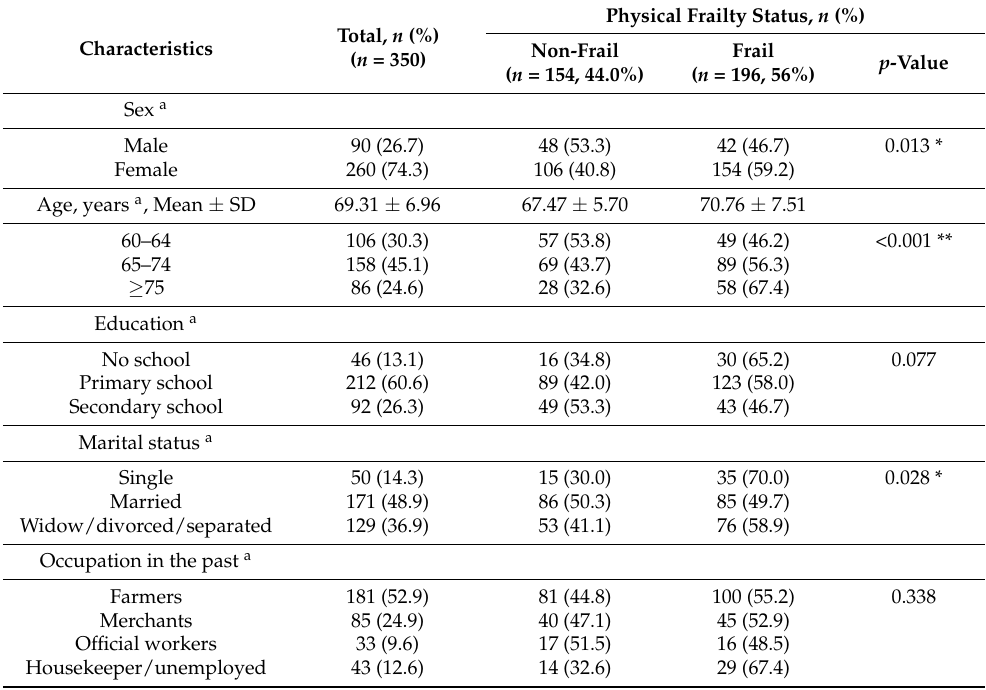
Table 1. Demographic and health characteristics of